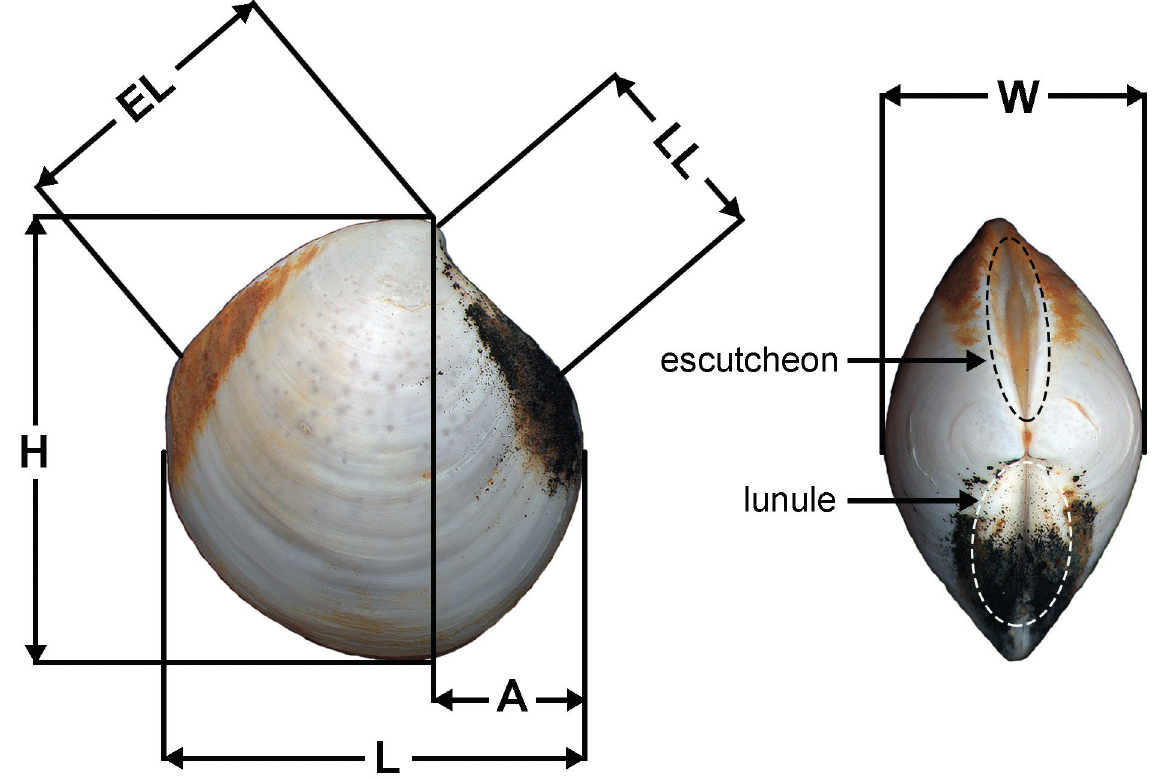
Fig. 1. Shell characters and measurements. Abbreviations: see Material and